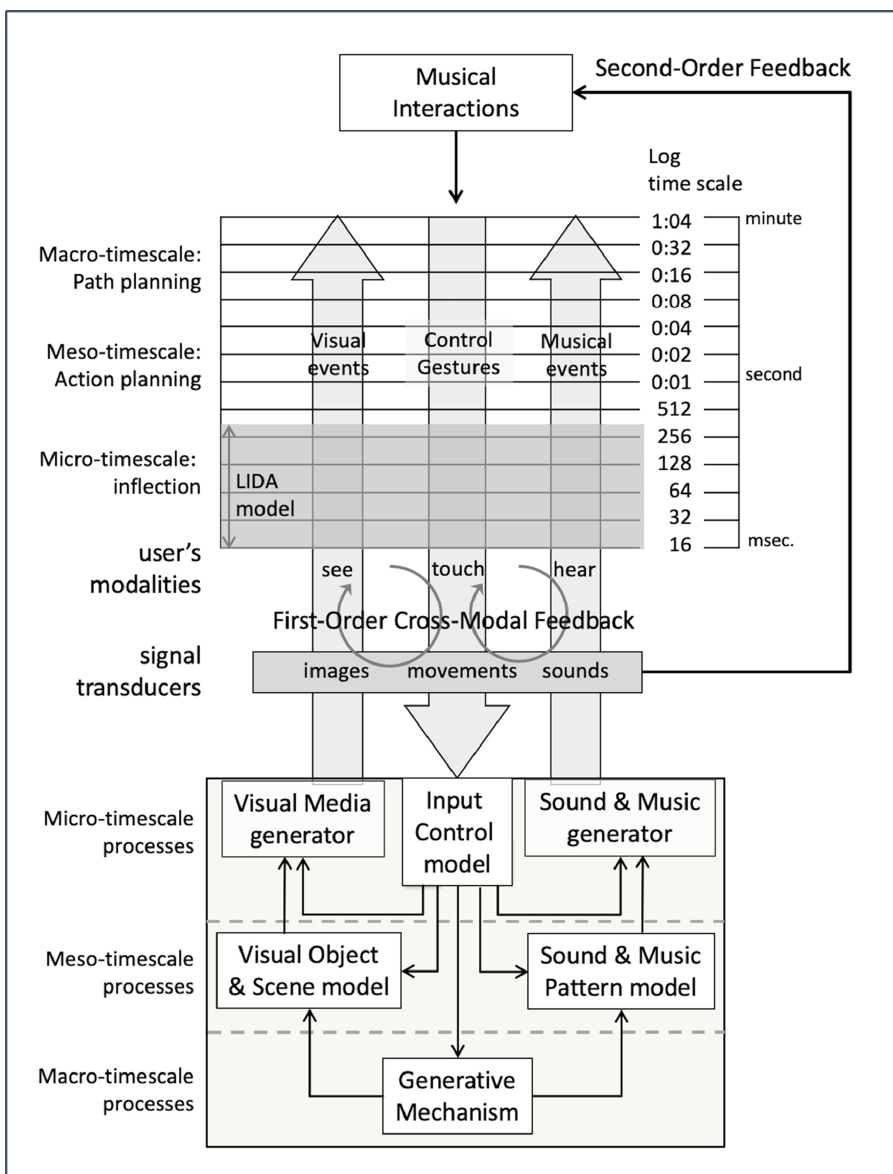
Figure 1. Schematic temporal integration architecture for musical interaction with multimodal and multimedia system: the parallel vertical data flows illustrate the interactive processes between user and system. A user’s action perception cycle is represented in the temporal regions of a cognitive cycle following the LIDA model [71,72]: a cycle constitutes the temporal windows of sensing, attending, and acting, engaging both pre-cognitive and cognitive processes. In this diagram, user input signals are converted into control data through a Generative Mechanism—a background process model—which routes control signals to parallel subsystems for generating sound and visual media. Users experience multisensory First-Order feedback. Users engage Second-Order feedback to observe multisensory outcomes with directed attention to auditory outcomes for action planning. In musical interaction, both levels of feedback cycles cascade in a continuous flow for sensing, attending, and acting. Adapted and modified from [74].